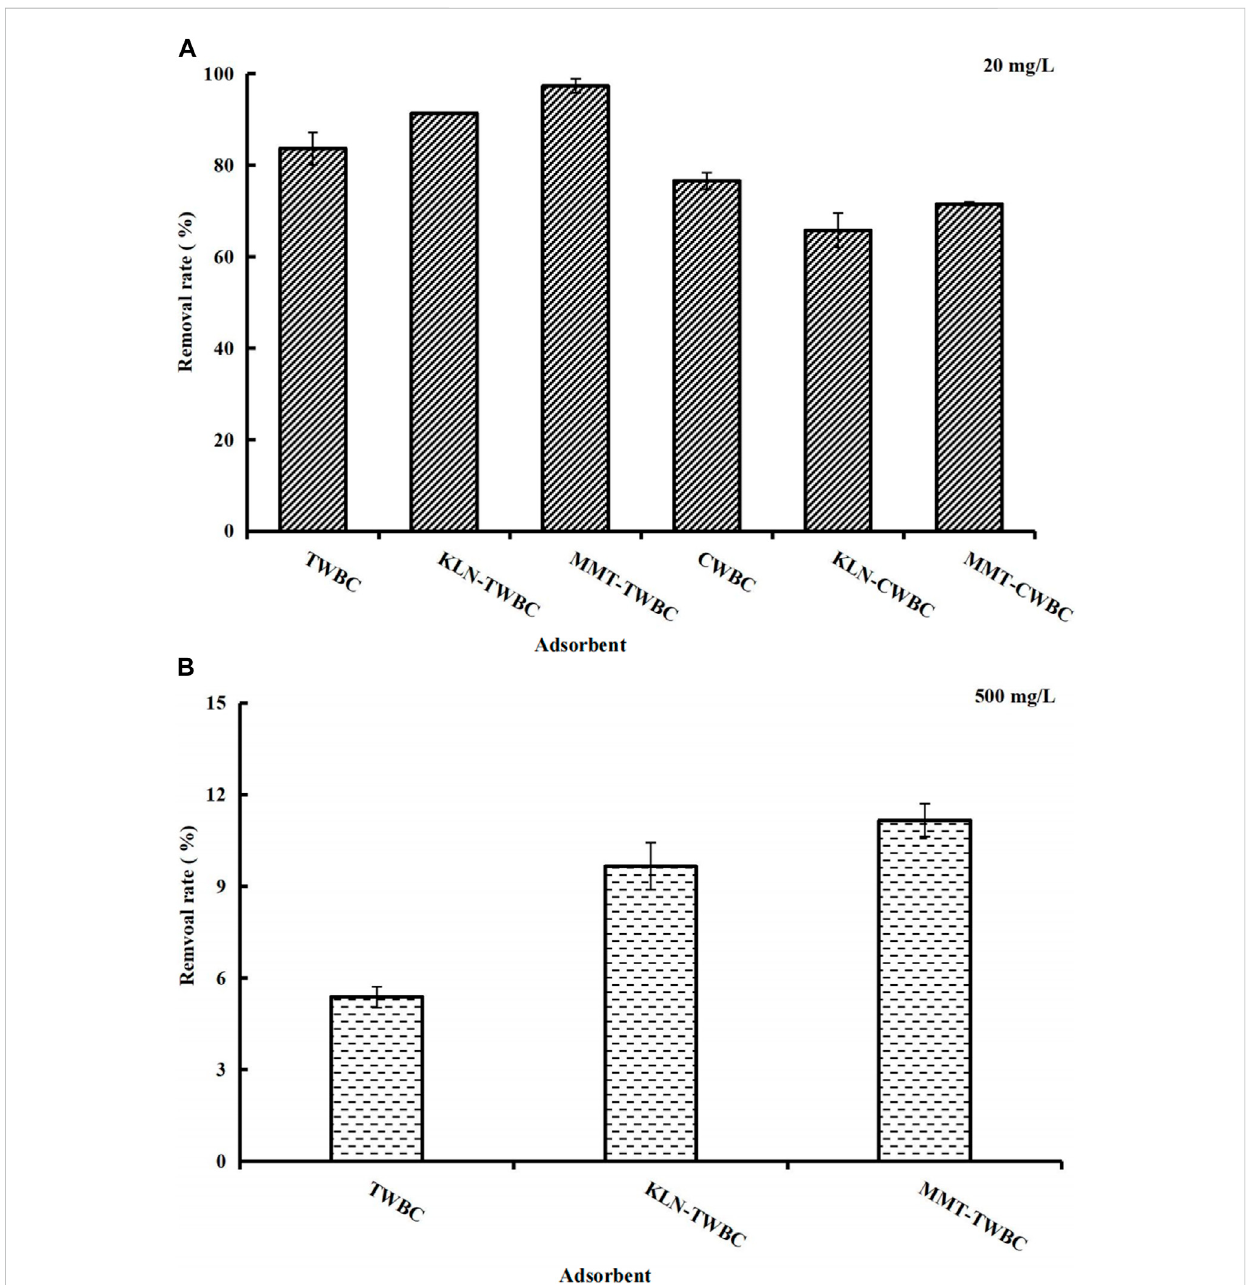
Removal rates of (A) low initial concentration (20 mg/L) MB by TWBC, KLN-TWBC, MMT-TWBC, CWBC, KLN-CWBC, MMT-CWBC, and (B) high initialconcentration(500 mg/L)MBbyTWBC,KLN-TWBC,MMT-TWBC(Contacttime48 h,temperature25 ° C±0.5 ° C,adsorbentdose2